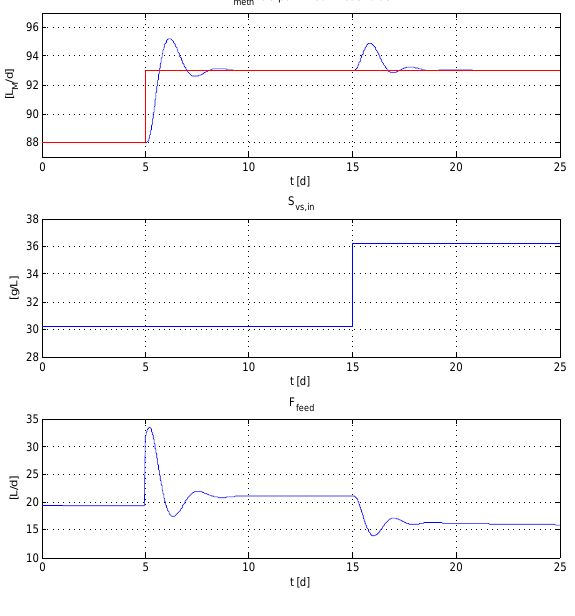
Figure 3: Simulated responses of the control system due to a setpoint step and a disturbance step in S vs . The PI controller is tuned with the in Skogestad